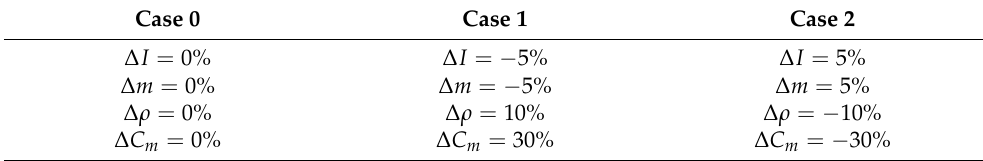
Table 1. The parameter uncertainty for 3 cases.